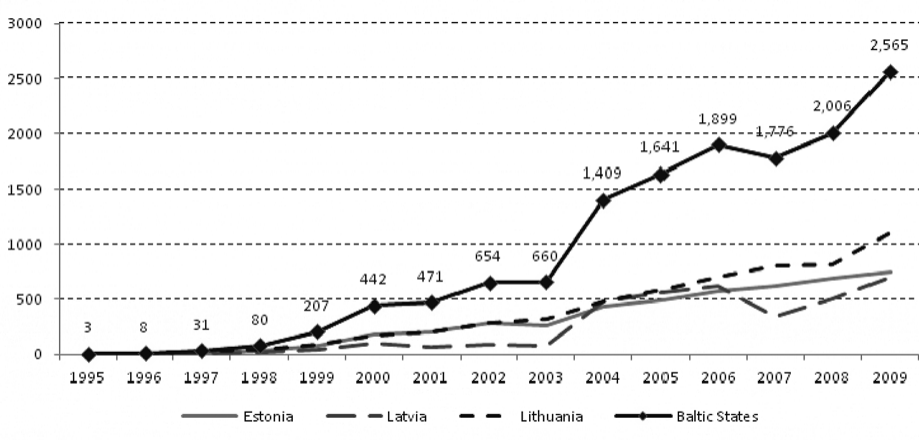
Fig. 5. Evolution of ISO 9000 certifications in the Baltic States Source: Own preparation on the basis of ISO full reports of global statistics for ISO 9000 (ISO, 1998-2010).